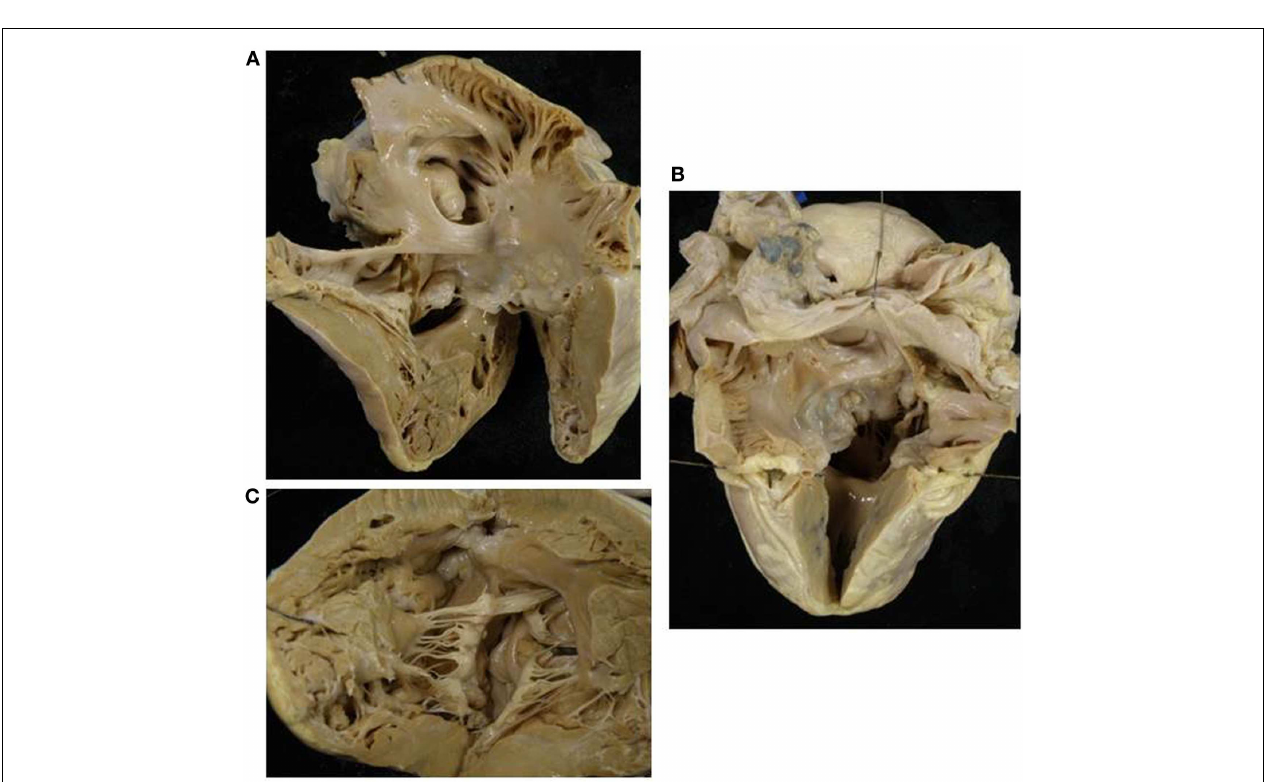
hypoplasia of the posterior left ventricle. (C) From the right ventricle both the aorta and the pulmonary artery take origin.The pulmonary outlet is stenotic. Note the common atrioventricular valve mostly connected to the right